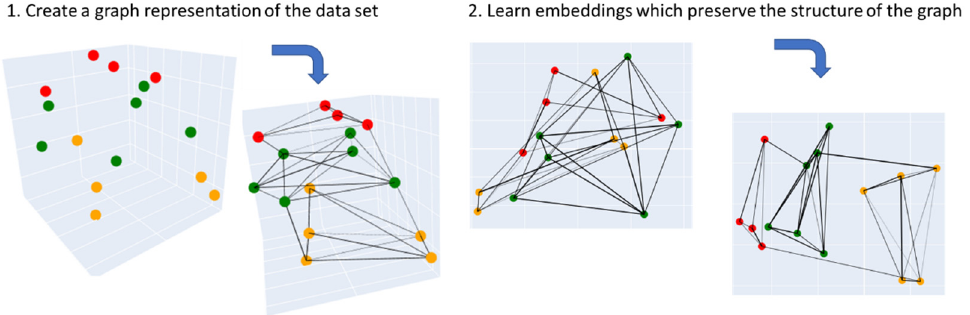
Figure 8. Visual explanation of how UMAP works. It first computes a graph representation of the input data, which is then used to learn embeddings that preserve the structure of the graph representation. Figures is redrawn based on ref. [57].